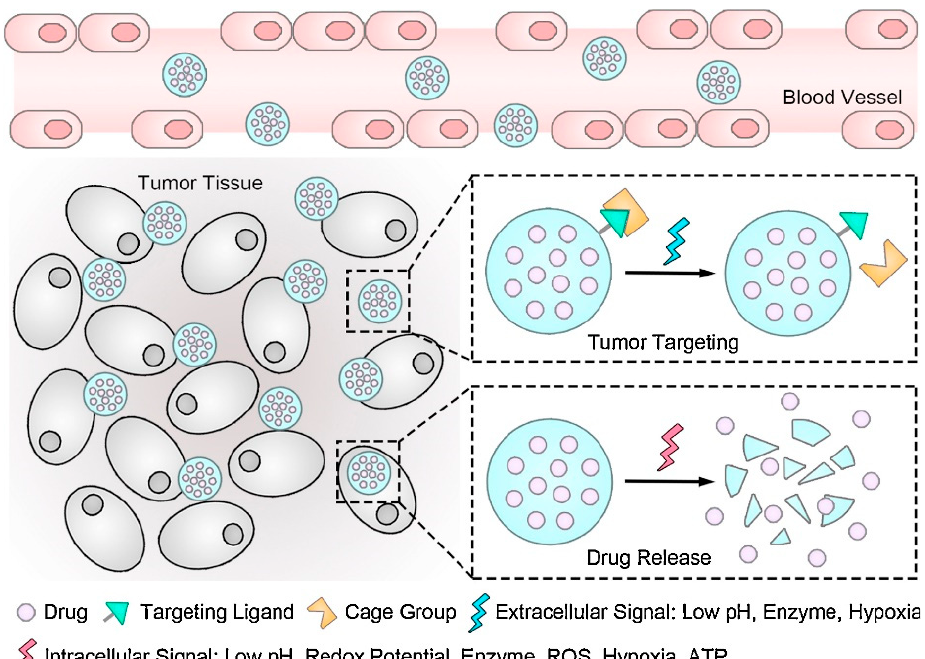
Figure 2. Schematic representation of the role of TME and intracellular signals in tumor targeting and controlled drug release. Reprinted from an open-access source [49]. Abbreviations: ATP—adenosine triphosphate; ROS—reactive oxygen species.